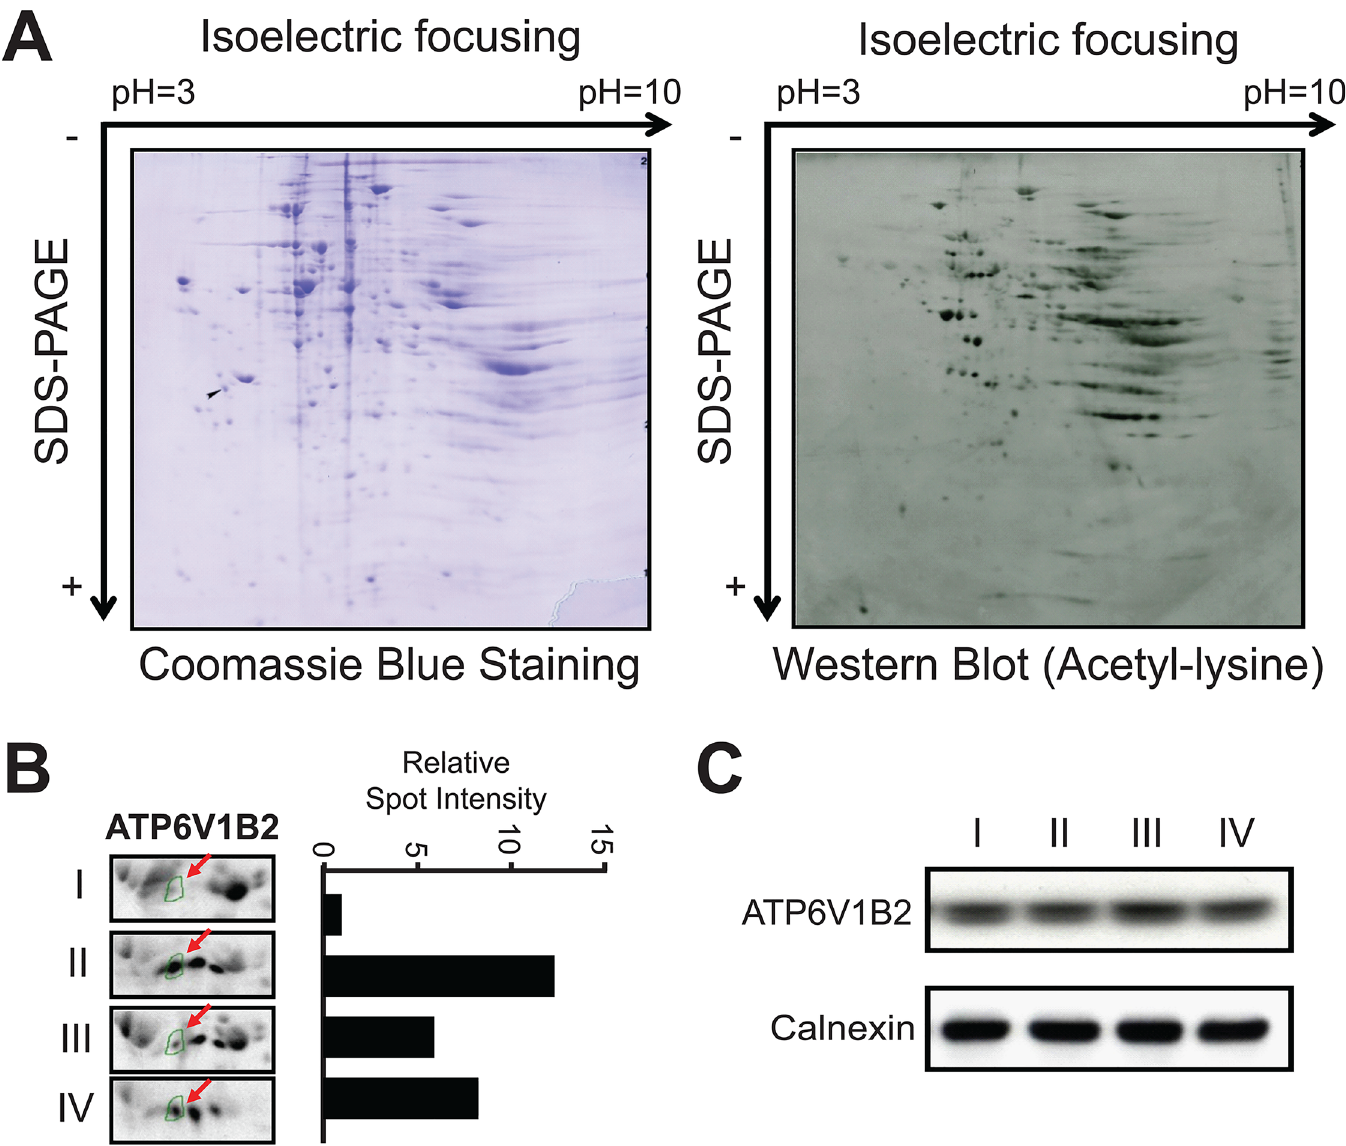
Fig 3. Proteomic analysis of SIRT1 modulator-treated 3T3-L1 mature adipocytes identified ATP6V1B2 as a potential SIRT1 target. (A) Representative 2D-PAGE gel transfer blot stained with Coomassie blue and utilized in western blot analysis using a pan-acetyl-lysine antibody. (B) Western blot spots corresponding to ATP6V1B2 showed differential acetylation states upon SIRT1 modulator treatments, as described in Fig 2A. The spot intensities were quantified and are shown as a bar graph in the right panel. The value for the blank control was arbitrarily set as one. (C) The protein level of ATP6V1B2 was examined by western blot analyses after SIRT1 modulator treatment of 3T3-L1 mature adipocytes. Calnexin was used as a loading